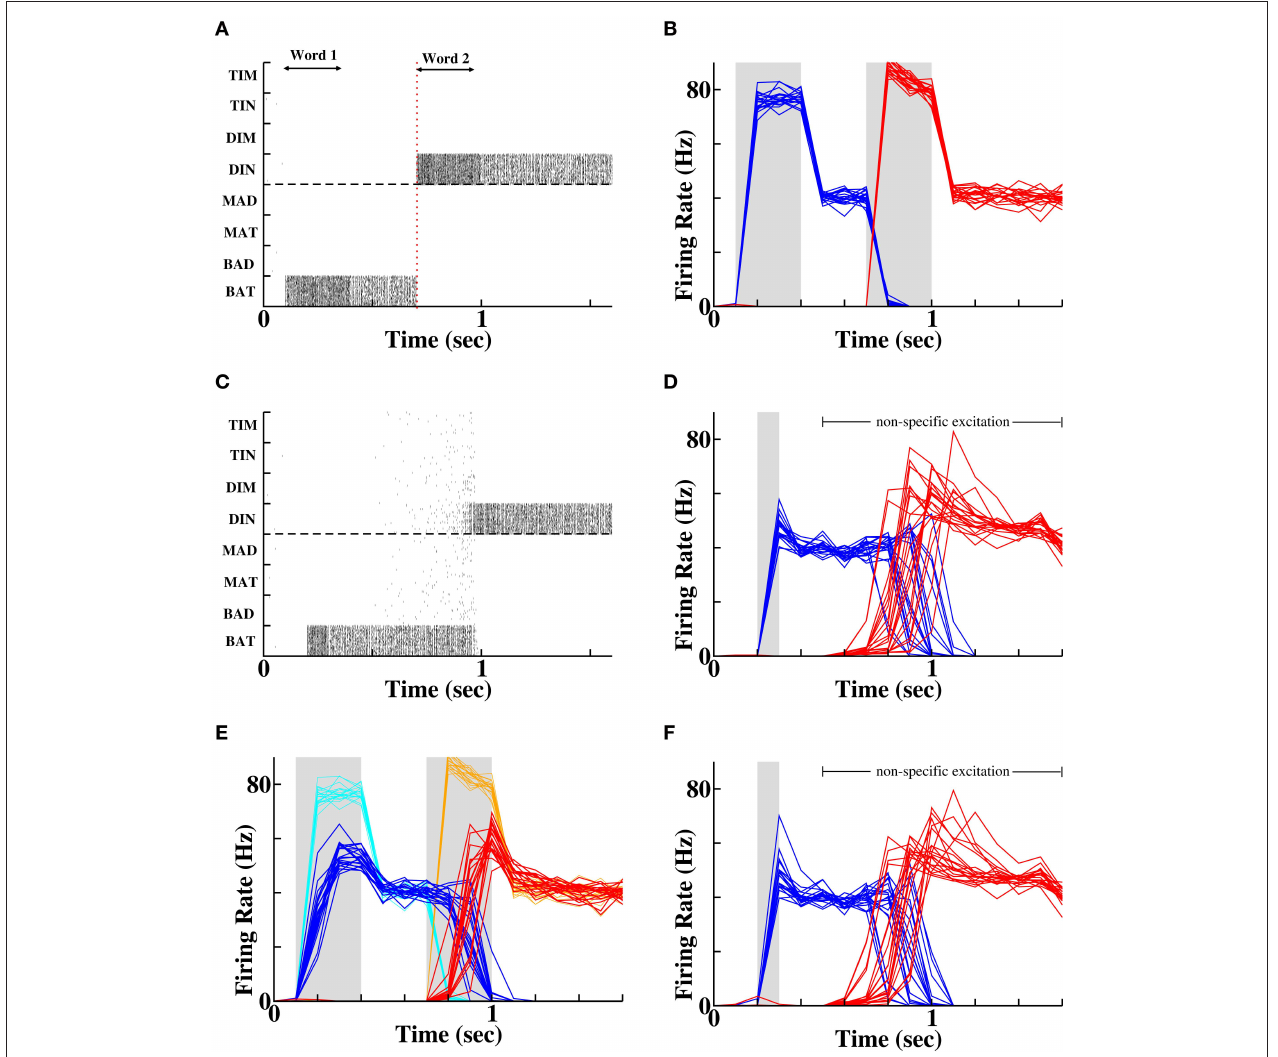
across 20 independent random instantiations, demonstrating recall of “DIN” following activation of “BAT”. Gray solid bar indicates time period when first word is activated. (e) Protocol of weaker stimulation produces weaker and delayed initial activity (dark blue and red traces) compared to control (light cyan and orange traces). Twenty random instantiations of the weaker stimulation protocol produce identical final activity to controls, signifying equivalent levels of word recognition. (F) Average firing rates of the two populations with prior weak stimulation, following reactivation of the first word. Recall probability is reduced from 100% control to 75% of instantiations (15 out of 20